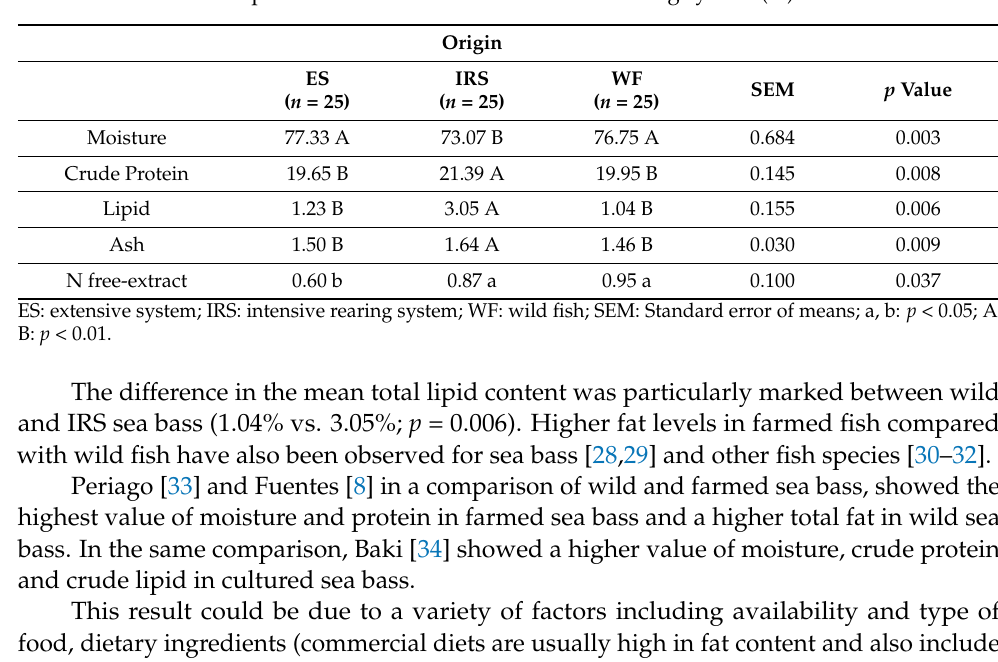
Table 3. Proximate composition of fillet of sea bass for each rearing system